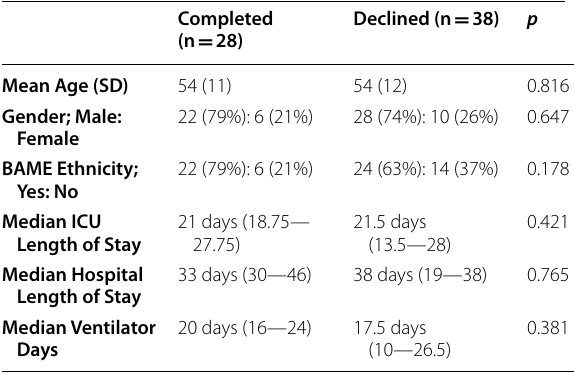
Table 1 : Demographic and clinical characteristics of patients who completed virtual rehabilitation and those who declined (n